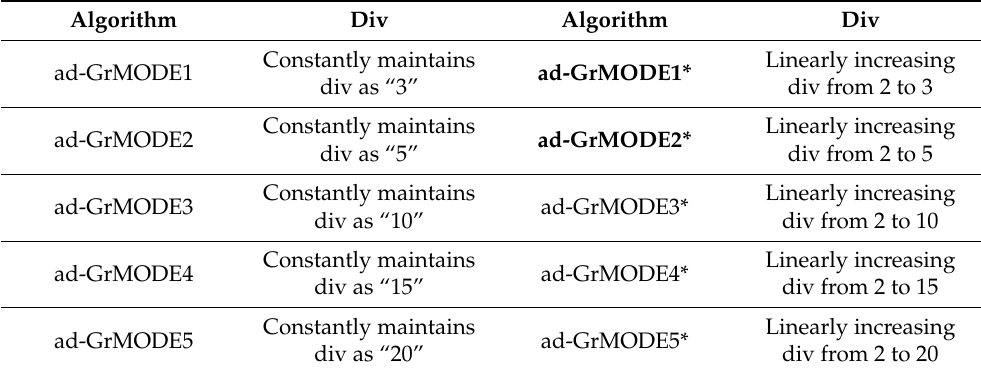
Table 2. Description of grid settings for the proposed